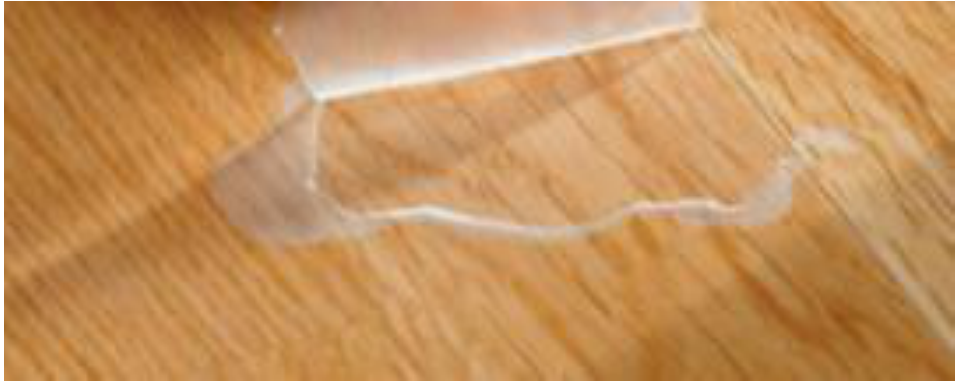
Figure 18. Clear coating failure.